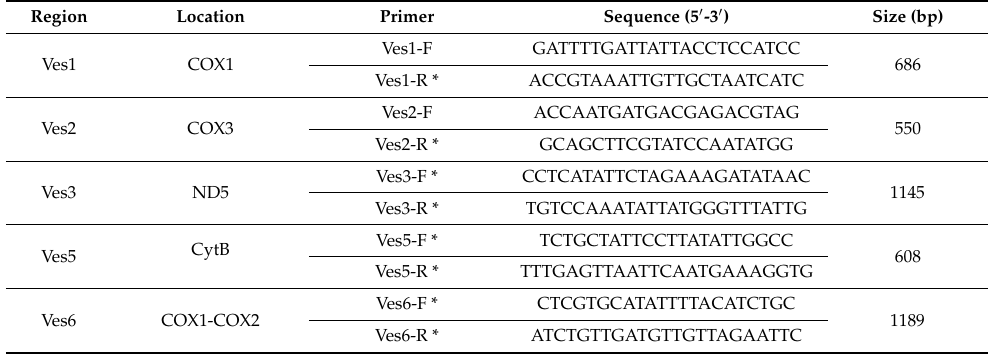
Table 1. Primers for PCR and Sanger sequencing of five polymorphic mitochondrial regions in Vespula germanica specimens collected in South Africa. * Sequencing primers.